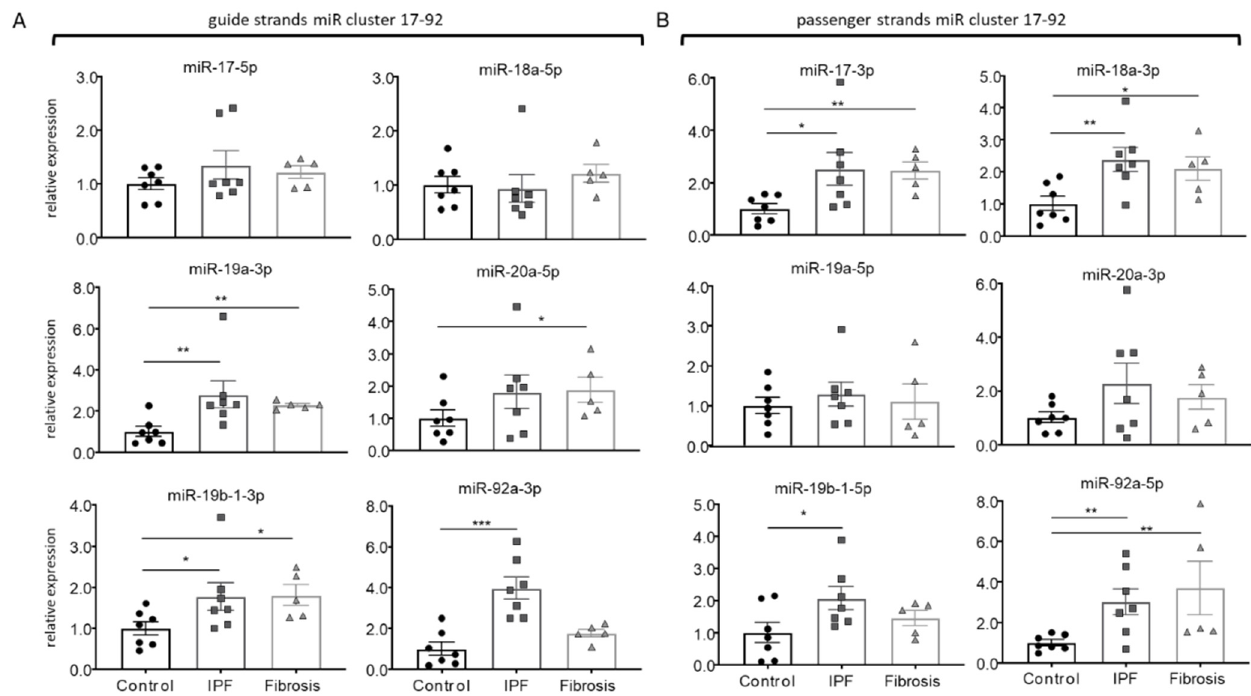
Figure 1. Disease-specific expression of miR17-92 members in isolated human primary cells. ( A ) Relative expression of guide strands miR17-92 in mesenchymal cells isolated from controls ( n = 7), idiopathic pulmonary fibrosis (IPF) patients ( n = 7), and interstitial lung fibrosis (Fibrosis) ( n = 5). ( B ) Relative expression of passenger strands miR17-92 in mesenchymal cells isolated from controls ( n = 7), IPF patients ( n = 7), and interstitial lung fibrosis ( n = 5). Bars represent mean ± SEM. * indicates p < 0.05, ** indicates p < 0.01, *** indicates p < 0.001.